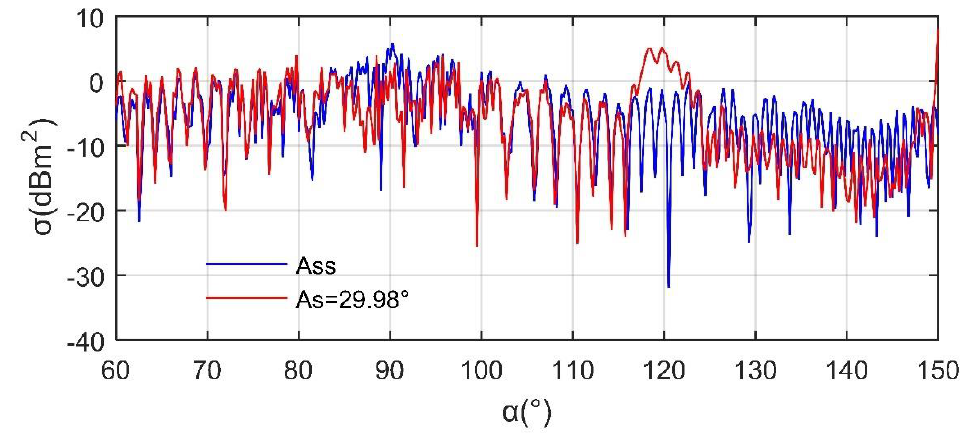
Figure 14. Comparison between initial individual and optimal individual, where α n = 60° , α m = 150°, β = − 6°, and F rv = 5 GHz.